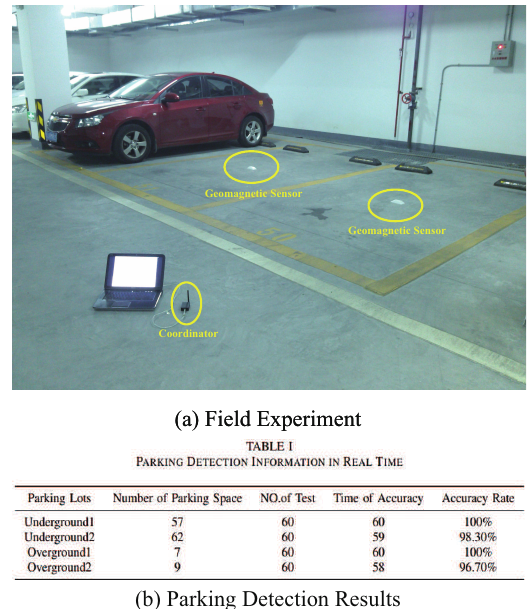
Fig. 5. Field Experiment Scene and Parking Detection Results in Real